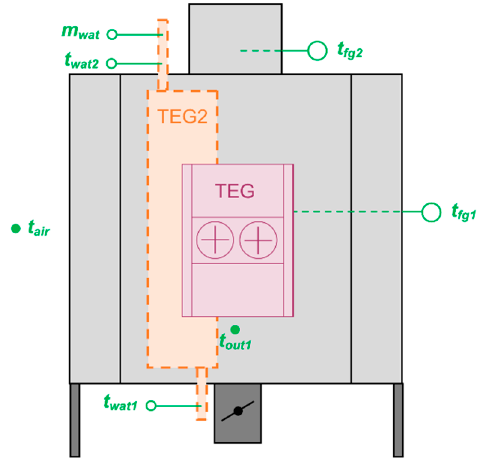
Figure 2. The scheme of the test rig showing the mounted thermoelectric generators (TEG1 and TEG2).